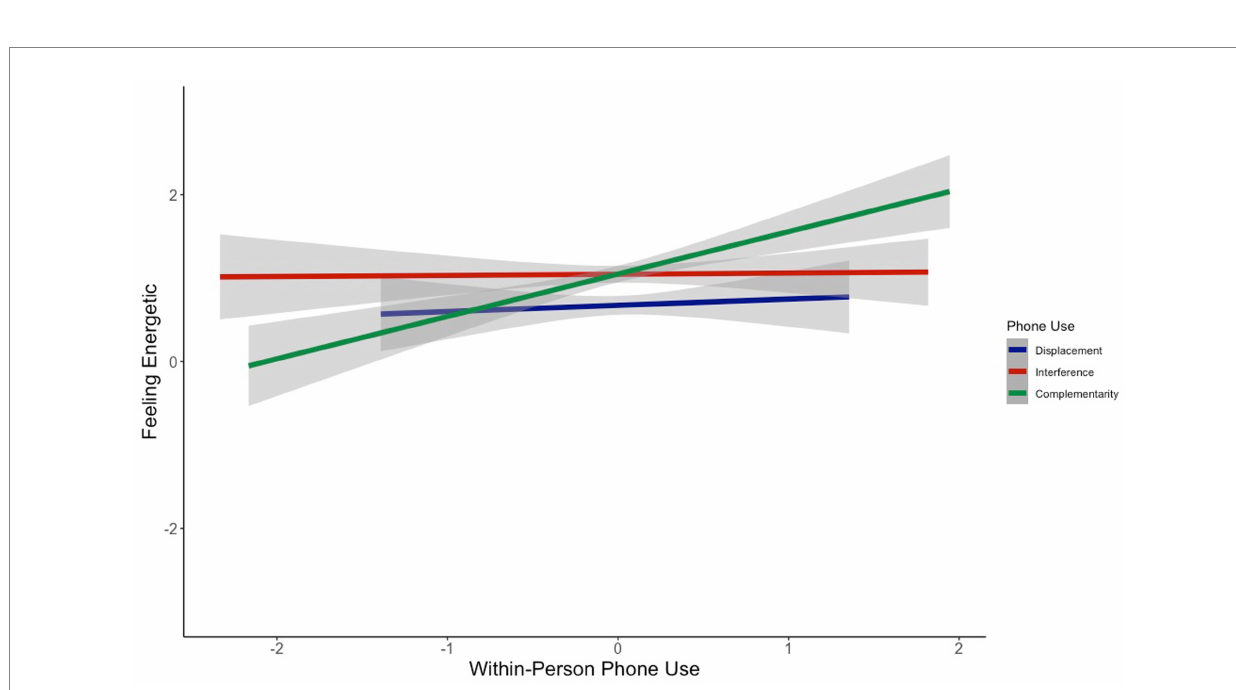
FIGURE 3 Association between within-person phone use and feeling